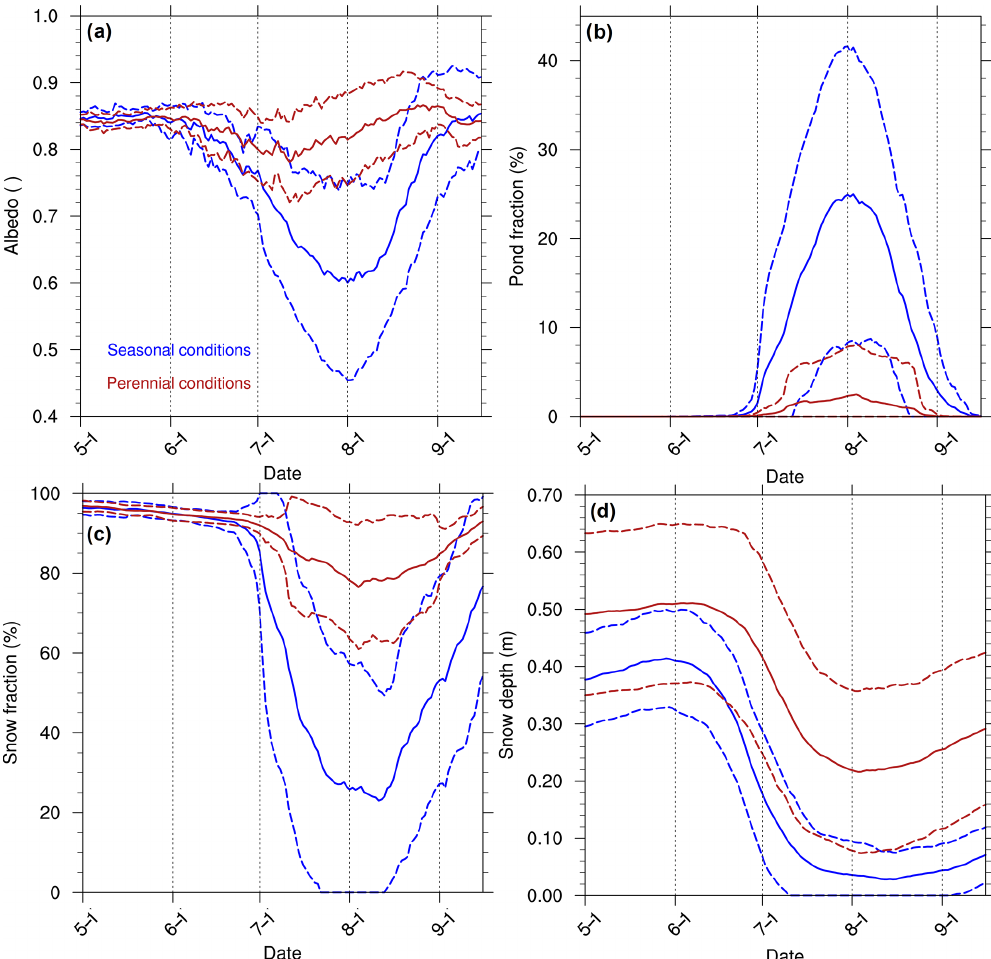
Figure 6. Melt season daily along-track mean sea ice albedo (a) , pond fraction of model grid cell (b) , snow fraction on sea ice (c) , and snow depth on sea ice (d) . The ensemble mean (solid) and ± 1 standard deviation envelope (dashed) are shown for seasonal (blue) and perennial (red) conditions. The melt season shown here corresponds to 1 May to 15